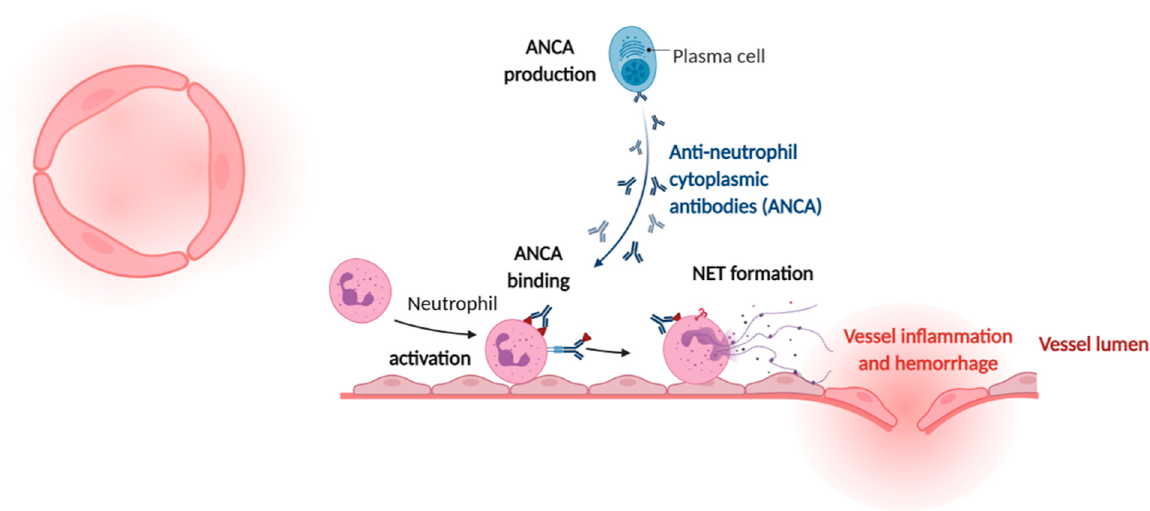
Figure 3. NETs in ANCA-associated vasculitis. ( Left ): Cross-section of a small vessel. ( Right ): Pathogenesis of ANCA- associated vasculitis is multifactorial, involving numerous immune cells. B lymphocytes feature prominently as producers of ANCAs, while activated neutrophils undergo NETs formation driving tissue damage via injury to the vascular endothelium (made with biorender.com, accessed on 4 June 2001).